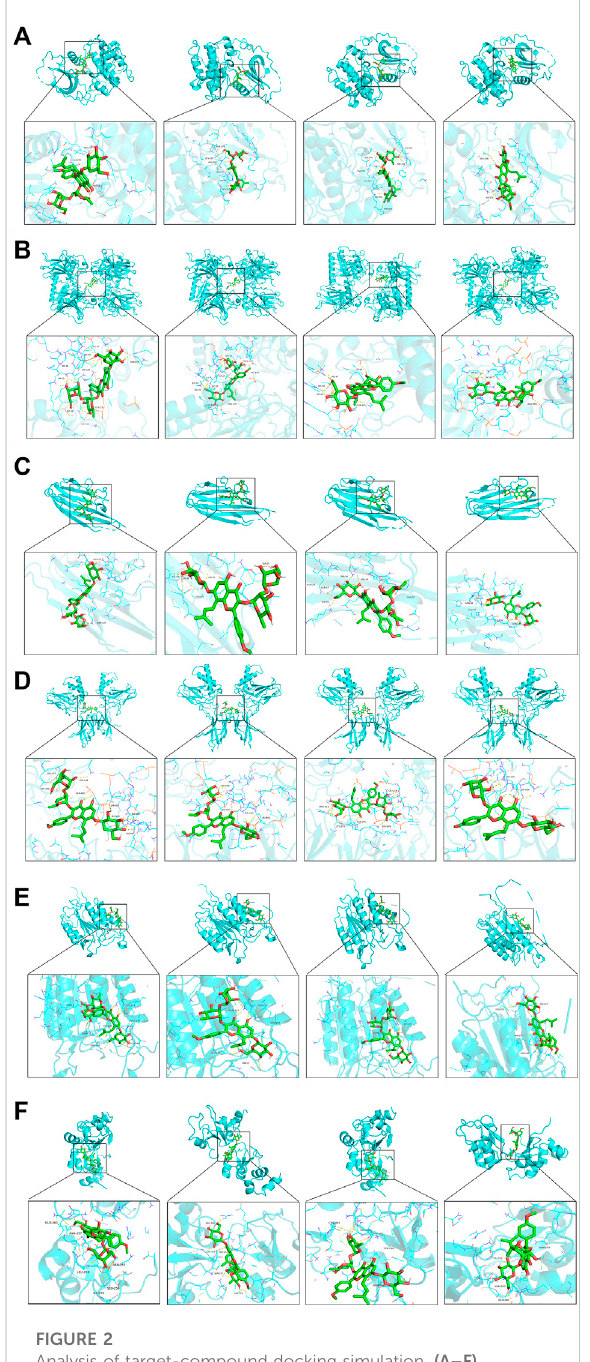
FIGURE 2 Analysis of target-compound docking simulation. (A –